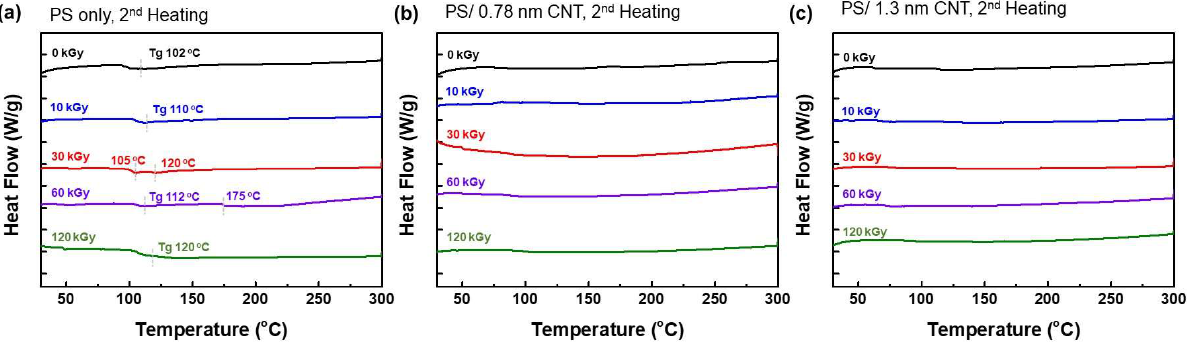
Figure 4. Changes in number-average molecular weight (Mn) of PS ( a ) and PS/SW-CNT composites with diameters of 0.78 nm ( b ) and 1.3 nm ( c ) under gamma irradiation. The FT-IR technique was used to track the changes in the chemical bonding between polystyrene and SW-CNTs (Figure 5). There is no significant change in chemical bonding when a 0.78-nm SW-CNT is introduced, but two peaks centered at 1250 cm −1 and 1050 cm −1 appear from 10–60 kGy when 1.3-nm SW-CNTs were introduced. These peaks ap- pear in alkyl aryl ethers, and the oxidation reaction occurs in the case of the 1.3-nm SW- CNTs composites through radiation energy.